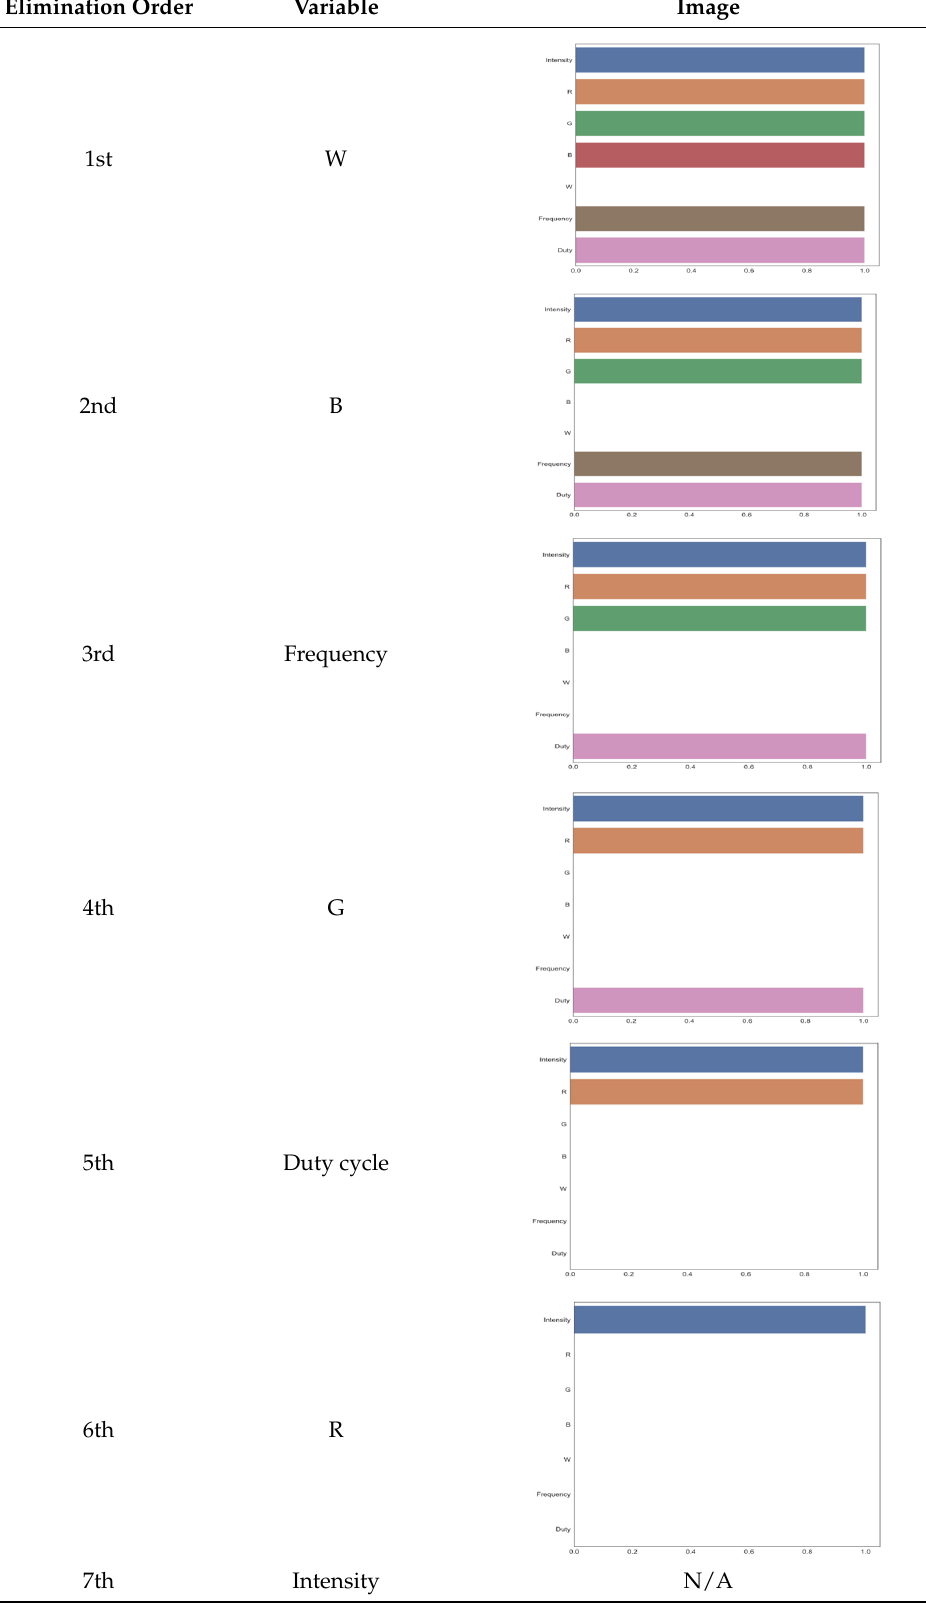
Table 11. Sequential feature selection by decision tree for depth =